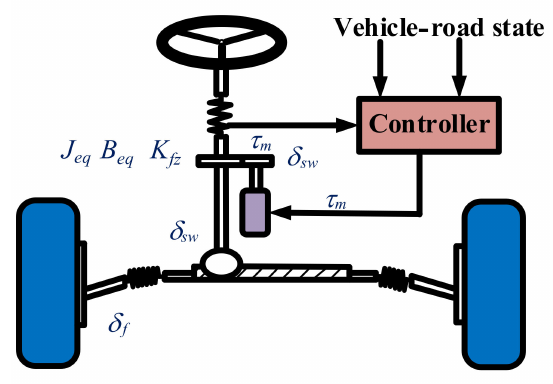
Figure 1. Schematic diagram of the steering